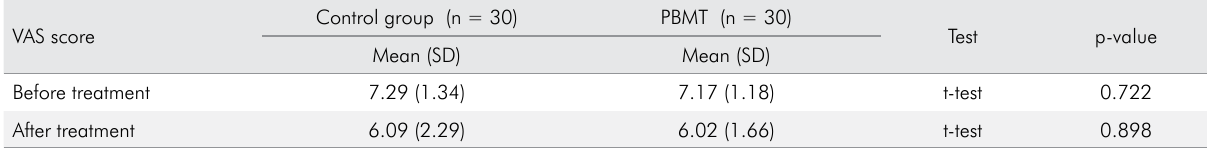
Table 4. Values for quantitative pain analysis using VAS score, before and after placebo and PBMT treatment. VAS score